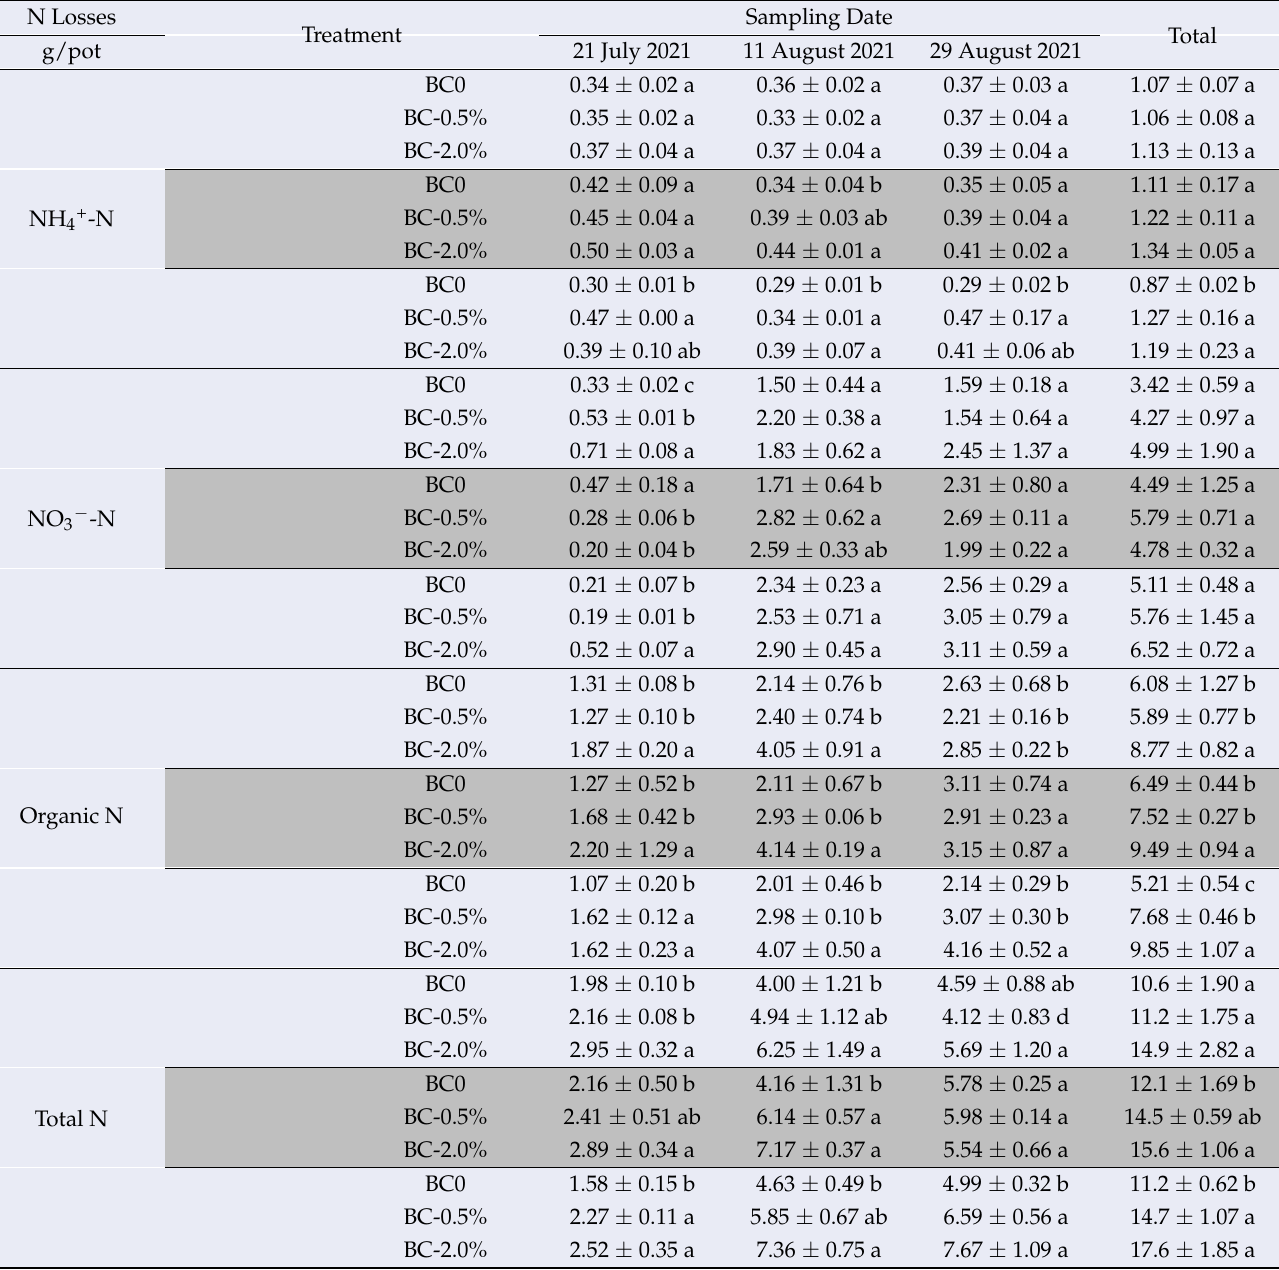
Table 3. Effects of hydrochar amending at two rates on NH 4+ -N, NO 3 − -N, organic and total N leaching losses from water-spinach-planted vegetable soil under three N